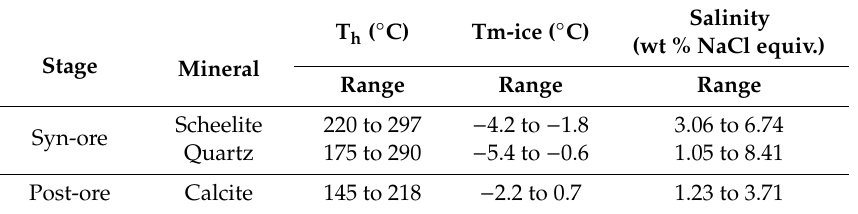
Table 2. Summary of microthermometric